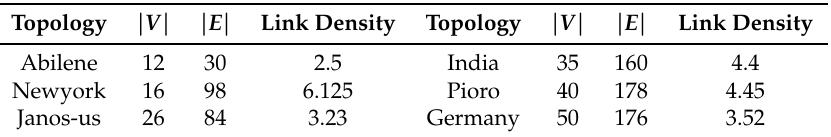
Table 1. The SND-lib topologies